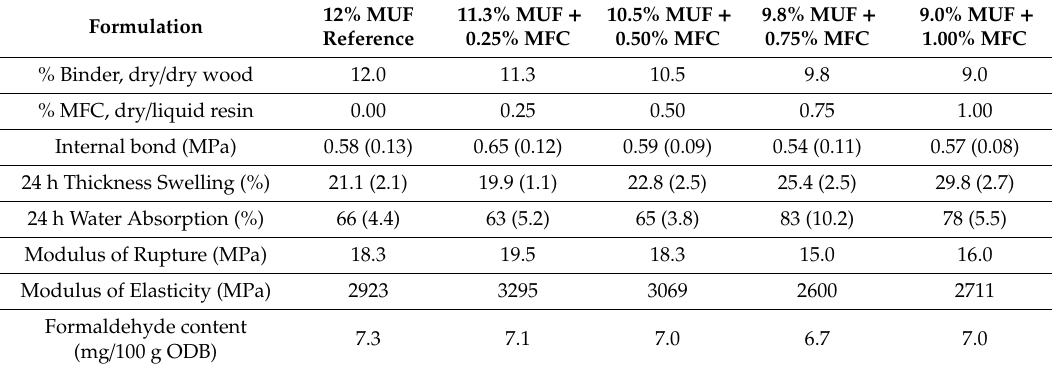
Table 9. Waferboard panels analysis, MFC 10% increasing levels, resin decreasing, Approach 2.